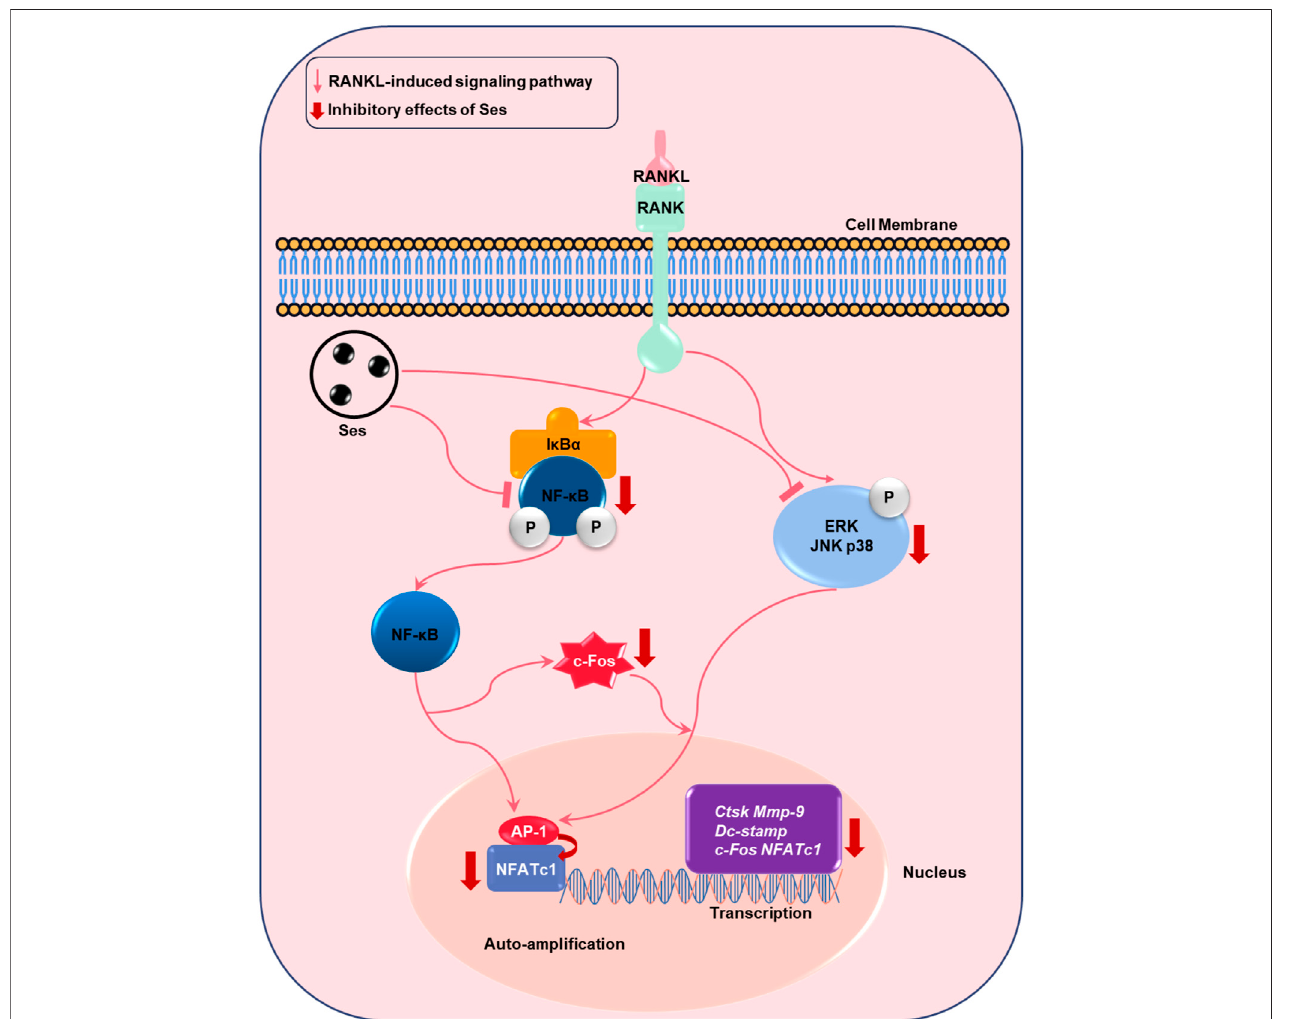
FIGURE 11 | Proposed scheme for Ses inhibition of osteoclast production. When RANKL binds to RANK, both the NF- κ B and MAPK pathways are activated, resulting in the ampli fi cation of c-Fos and NFATc1. Some genes speci fi cally expressed in osteoclasts are upregulated, such as Ctsk , Mmp-9 , Dc-stamp , c-Fos and NFATc1 . These signaling events are mediated by NF- κ B and MAPK signaling activation induced by RANKL. Our results demonstrate for the fi rst time that Ses inhibits osteoclast formation by inhibiting the production of NF- κ B and MAPK signals induced by RANKL. Ses, sesamolin; RANKL, receptor activator of nuclear facto- κ B ligand; NF- κ B, nuclear factor- κ B; MAPKs, mitogen-activated protein kinases; AP-1, activating protein 1; c-Fos , proto-oncogene C-Fos; Ctsk , cathepsin K; Mmp-9 , matrix metalloproteinase-9; Dc-stamp , dendritic cell-speci fi c transmembrane protein; NFATc1 , nuclear factor of activated T cells